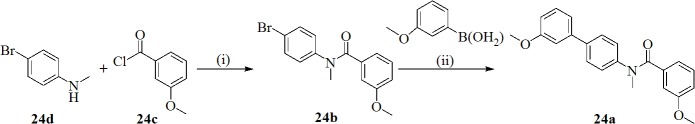
Synthesis of 1,4-Phenyl Retroamide Derivative 24a.Reagents and conditions: (i) Et3N, CH2Cl2, room temperature, overnight; (ii) DME/EtOH/H2O (1:1:1), Cs2CO3, Pd(PPh3)4, microwave irradiation (150°C, 150W, 20 min).